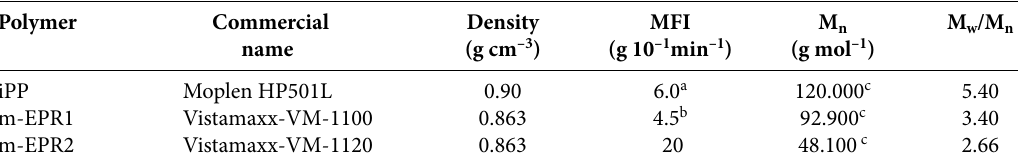
Table 1. The properties of used materials Polymer